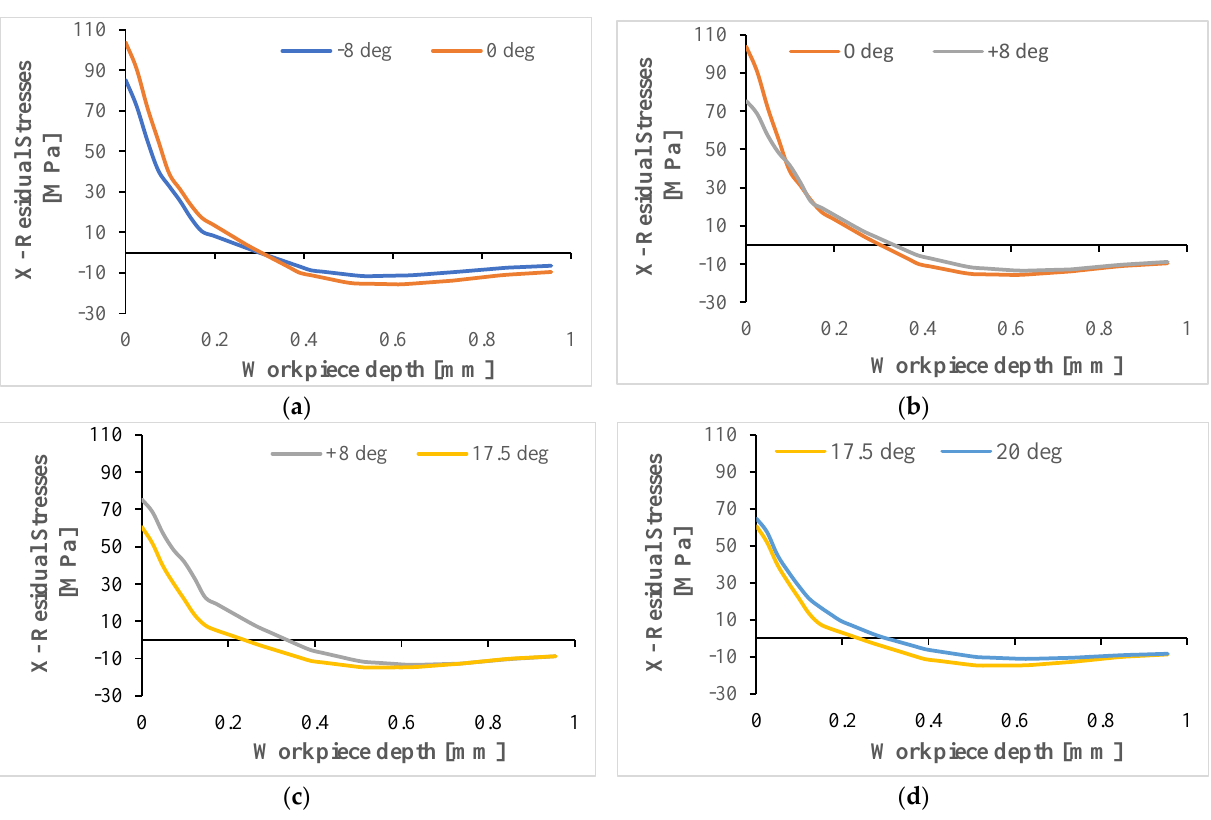
Figure 17. Residual stresses profile for various rake angles (α = 7° and 𝑟 𝜀 = 20 µm): ( a ) −8°, ( b ) 0°, ( c ) 17.5°, and ( d ) 20°.